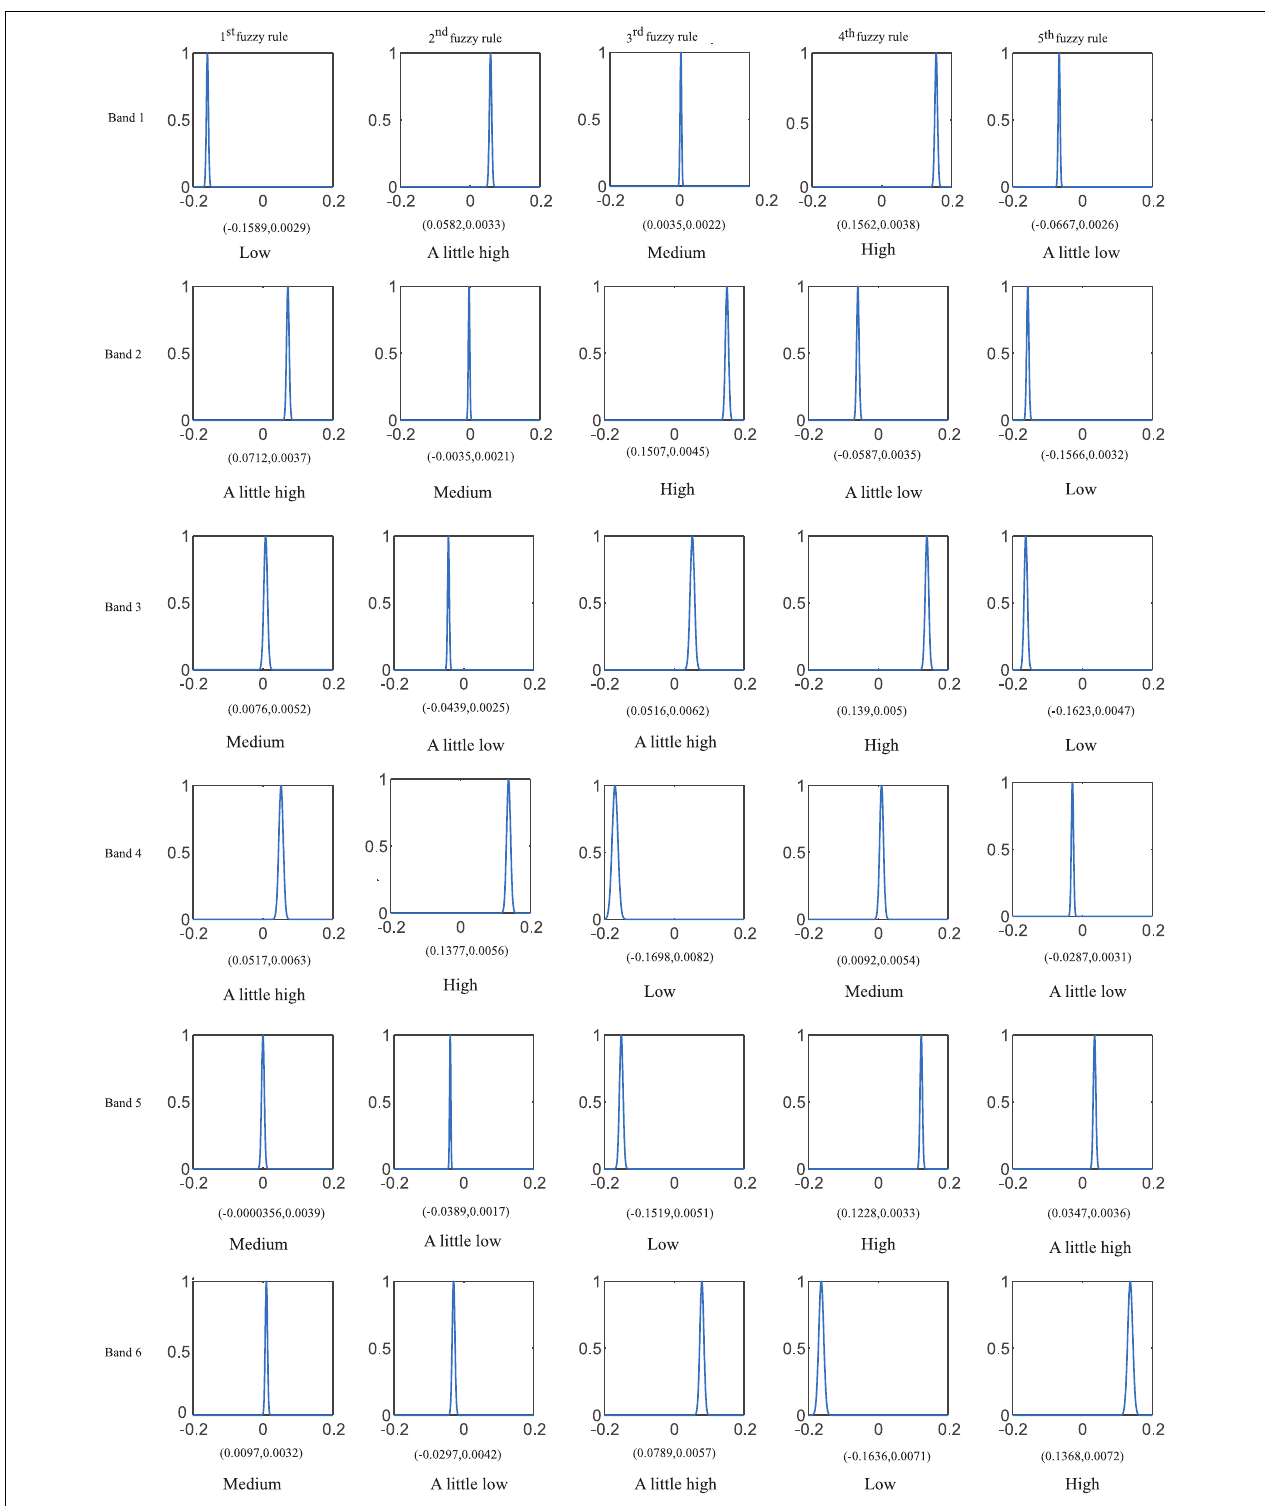
FIGURE 6 | The membership function of each fuzzy rule and the linguistic interpretation of each fuzzy subset of the TSK fuzzy system are obtained from the KPCA view.